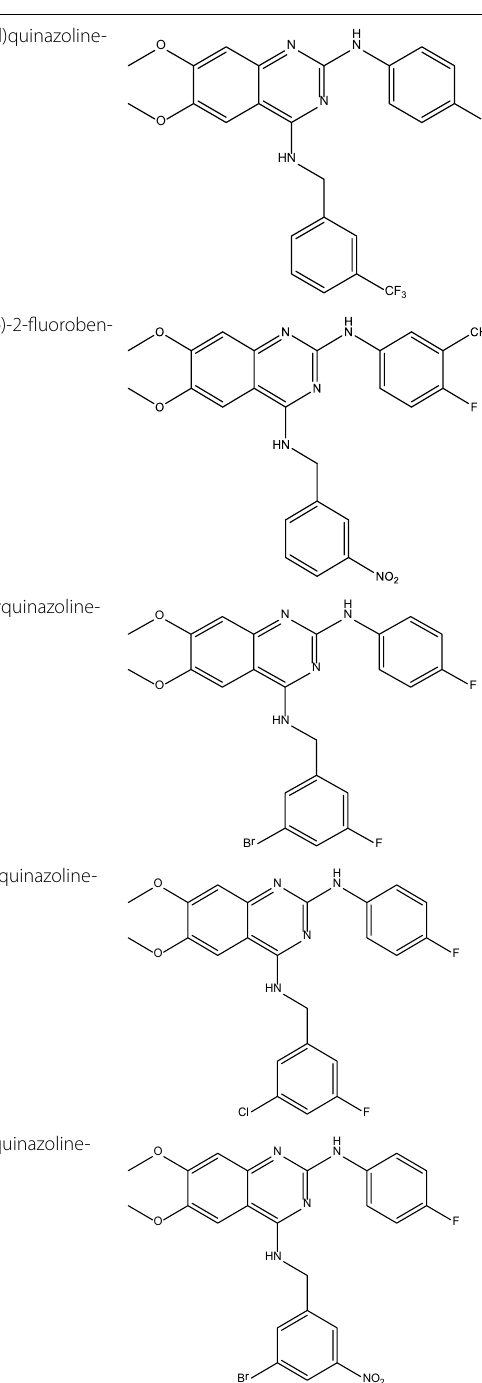
Table 1 Molecular formula, IUPAC Names, and structures of the designed derivatives of 2-anilino 4-amino substituted quinazolines S/N